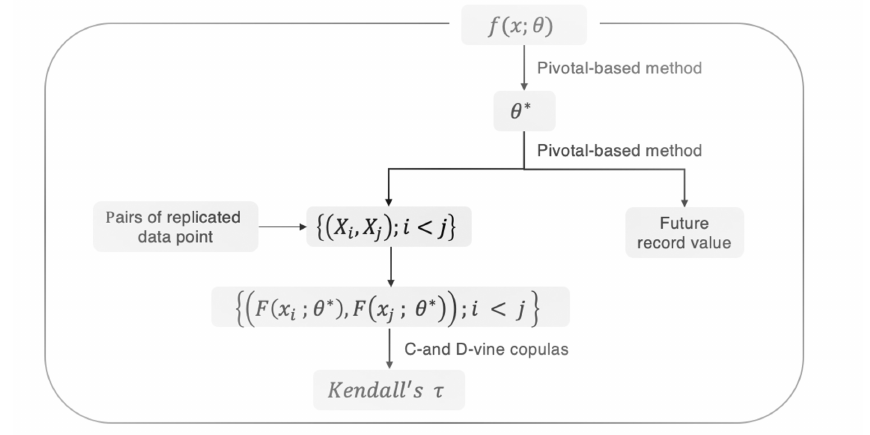
Figure 1. Schematic